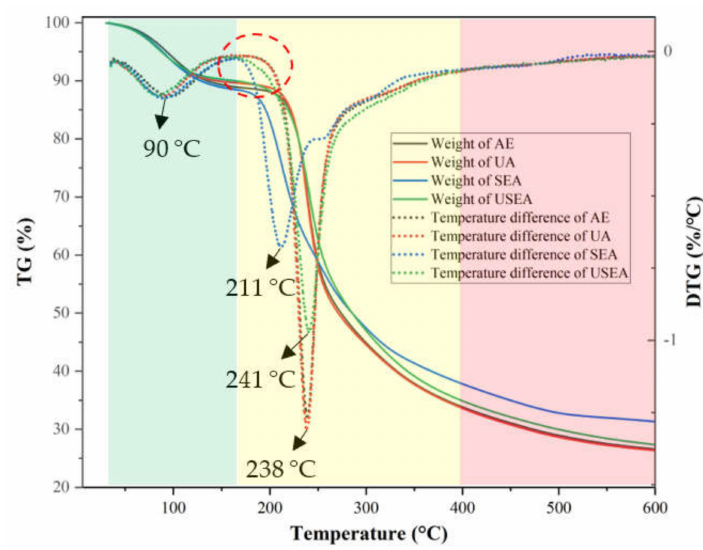
Figure 3. Thermodynamic characteristic of